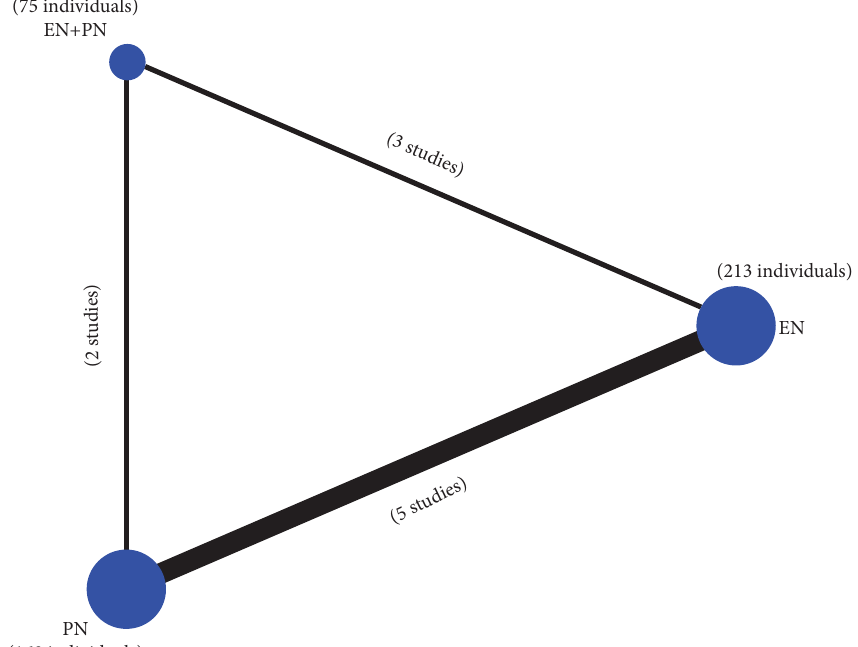
Figure 5: Te comparison network of the included